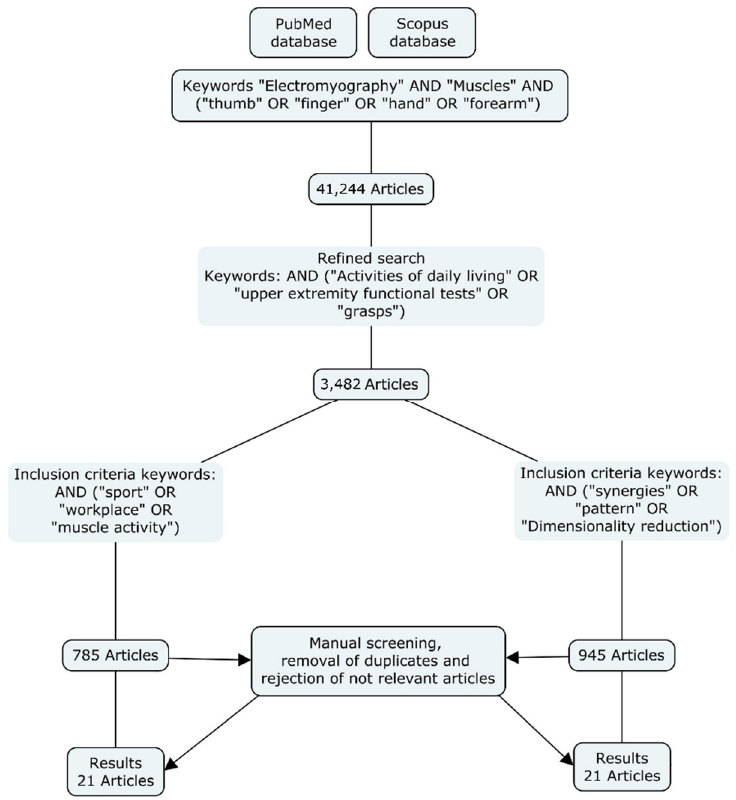
Figure 1. Methodology followed for the literature search.